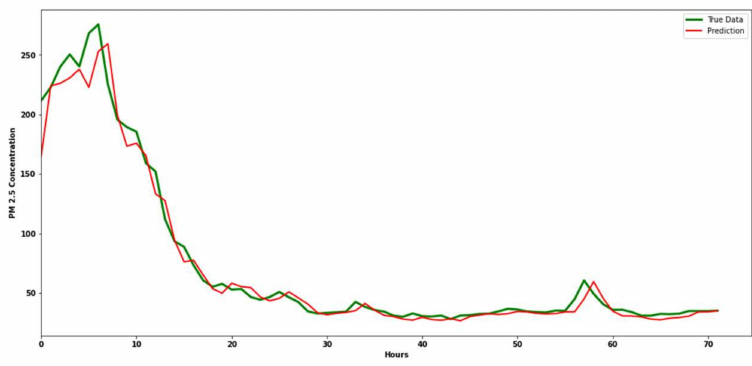
Figure 28. Forecasting for the next 72 h for Karachi using the LSTM model.